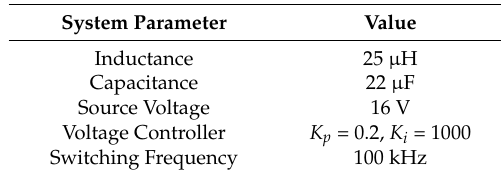
Table 2. System parameter values used for interface circuit effects.